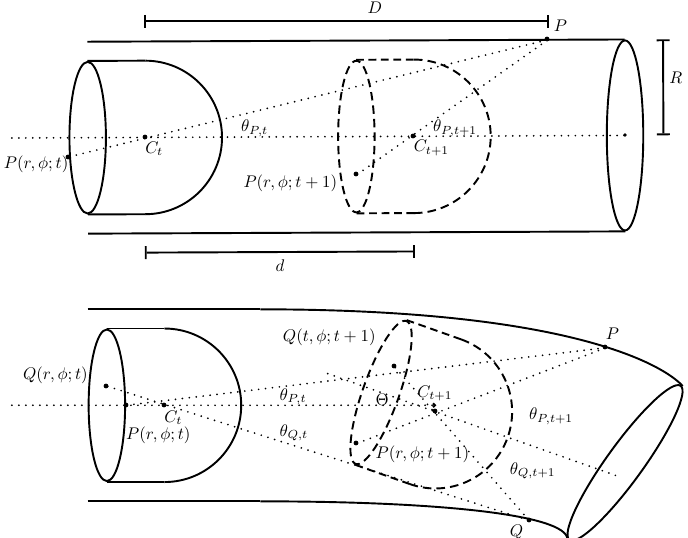
Figure 3. ( Top ) Illustration of a camera head in a cylinder at time t and later at time t + 1 moved by a distance d ; and ( Bottom ) illustration of a camera head in a cylinder at time t and later at time t + 1 but with the cylinder symmetry axis inclined by Θ . Drawing not to